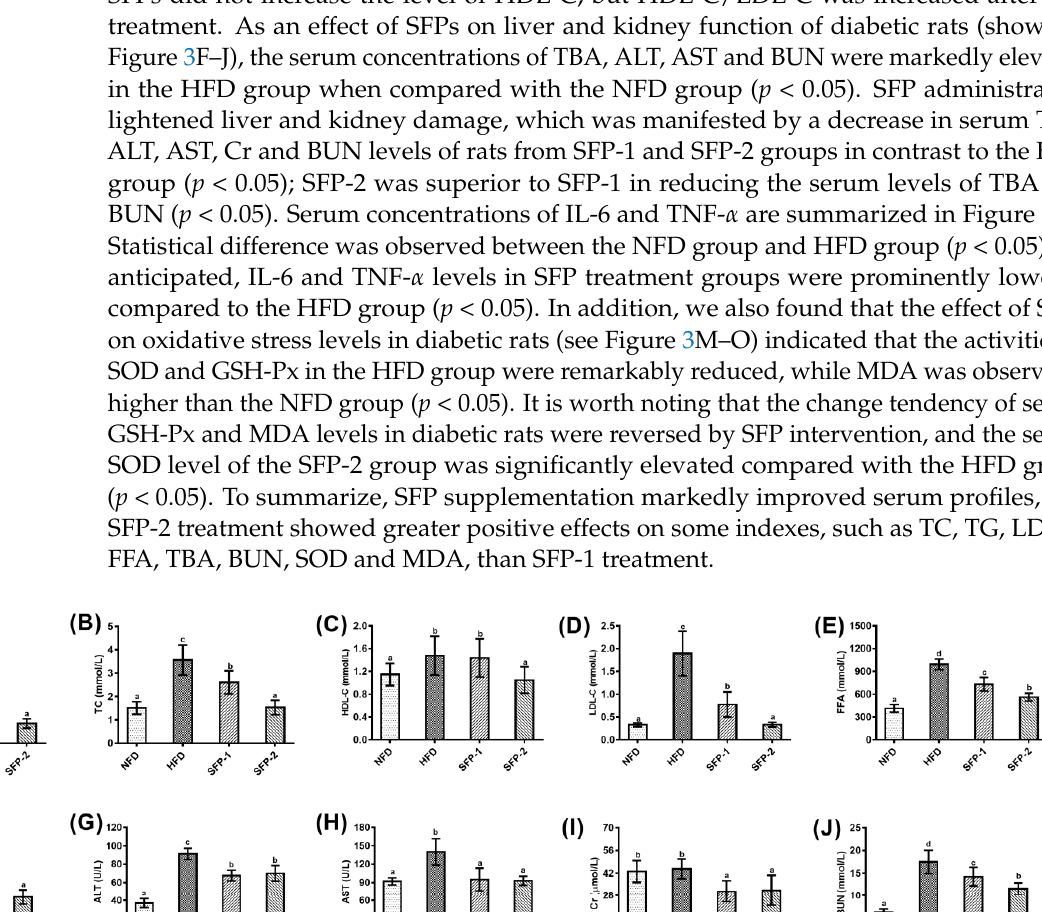
7 of 16 Figure 2. Effects of SFPs on body weight ( A ), food intake ( B ), water intake ( C ), fasting blood glucose level ( D ), HbA1c ( E ), insulin ( F ), AUC ( G ) and HOMA-IRI ( H ) in diabetic rats. The different letters represent significant difference ( p < 0.05). 3.3. Effects of SFPs on Serum Profiles in Diabetic Rats Accumulating data have suggested that diabetes mellitus is associated with a high